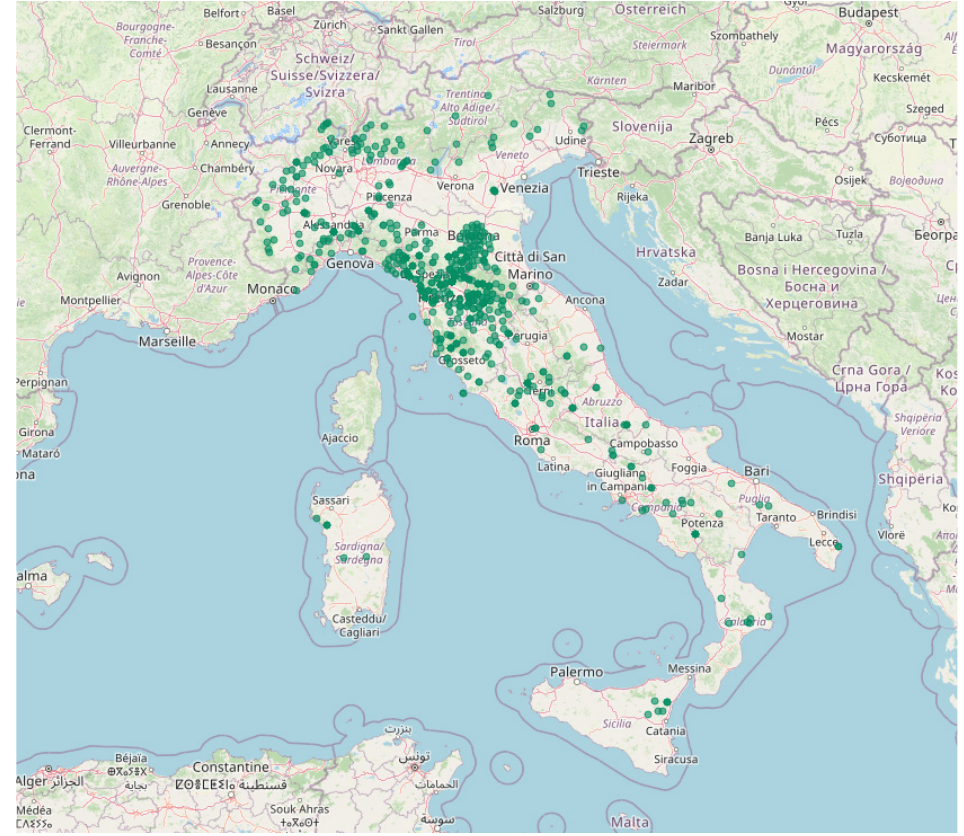
Figure 1. Location of the 9585 cadaster parcels subscribed by 684 users in Forest Sharing ® platform.